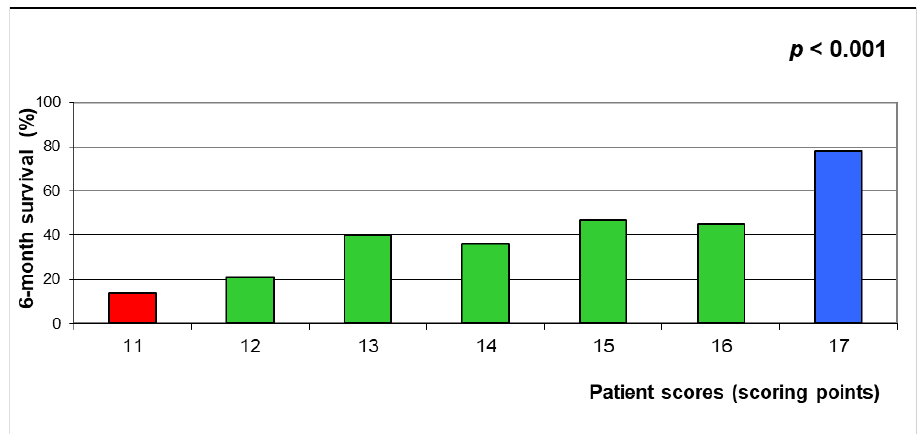
Figure 4. Model 3 (including KPS, number of lesions, age, and extra-cerebral metastases): Six-month survival rates of patient scores ranging between 11 and 17 points.